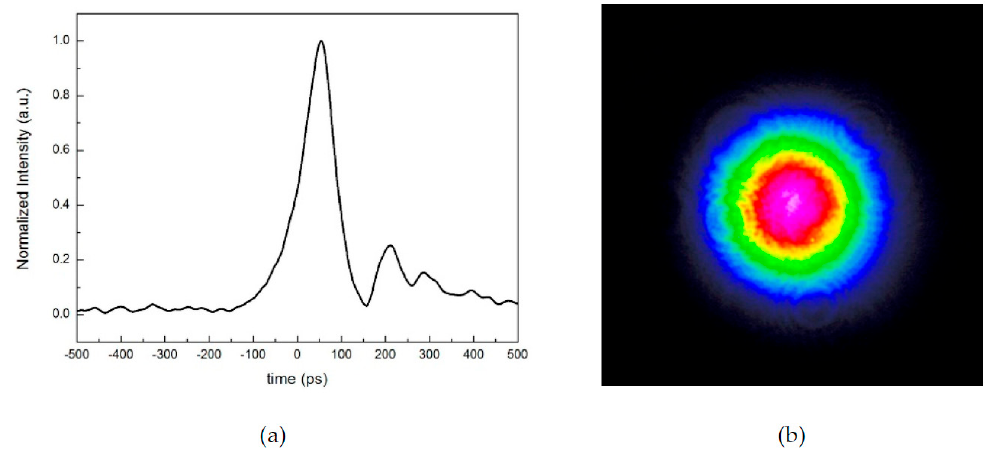
Figure 2. ( a ) Temporal profile and ( b ) beam distribution of amplified pulses from the regenerative